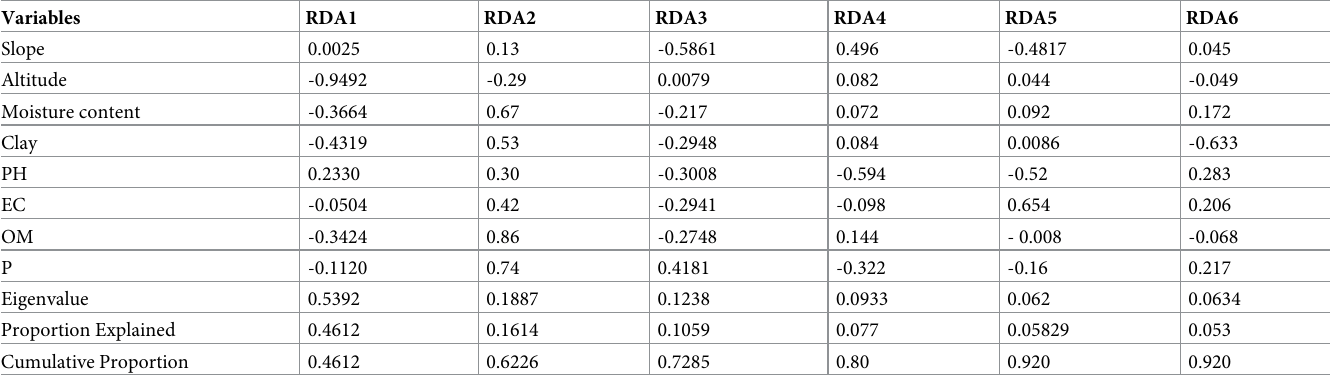
Table 8. Biplot scores for constraining variables.